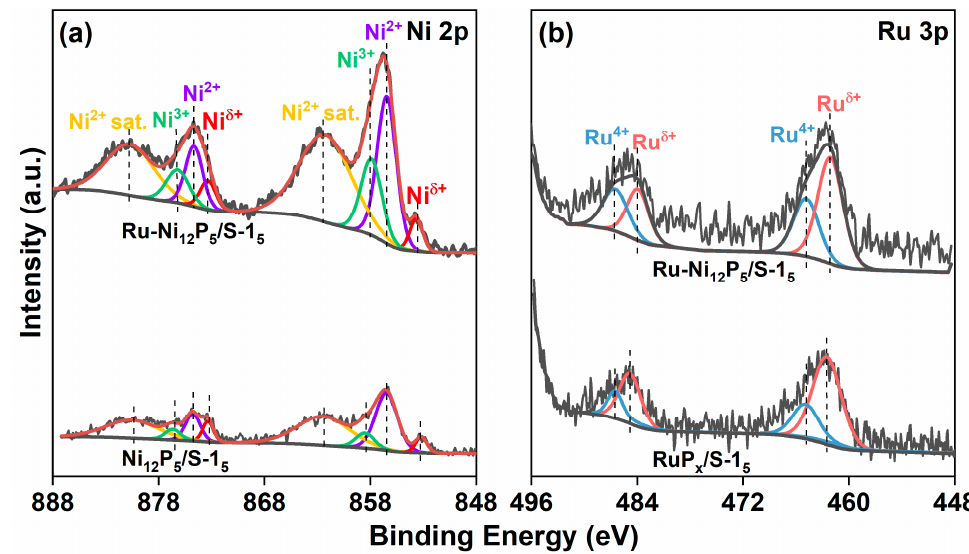
Figure 4. X-ray photoelectron spectrum of Ru-Ni 12 P 5 /S-1 5 in ( a ) Ni 2p and ( b ) Ru 3p regions.